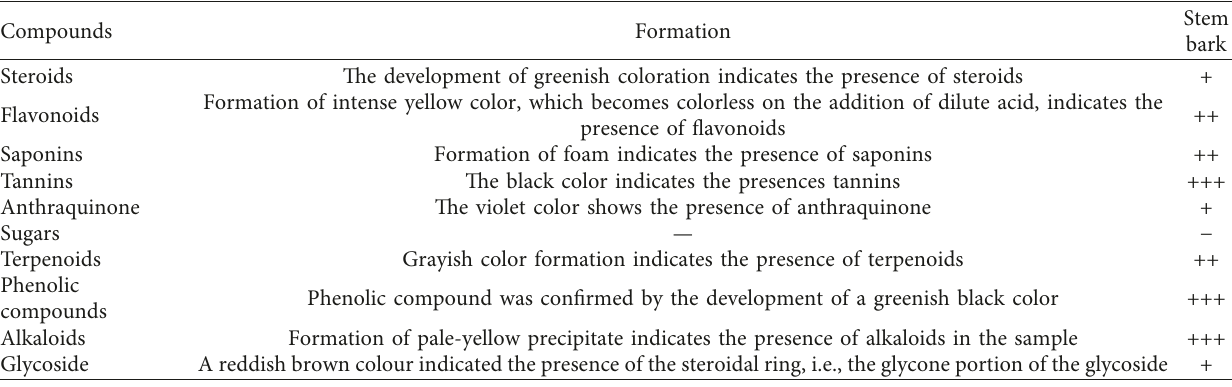
Table 2: Phytochemical analysis of S . gigas stem bark methanolic extract.